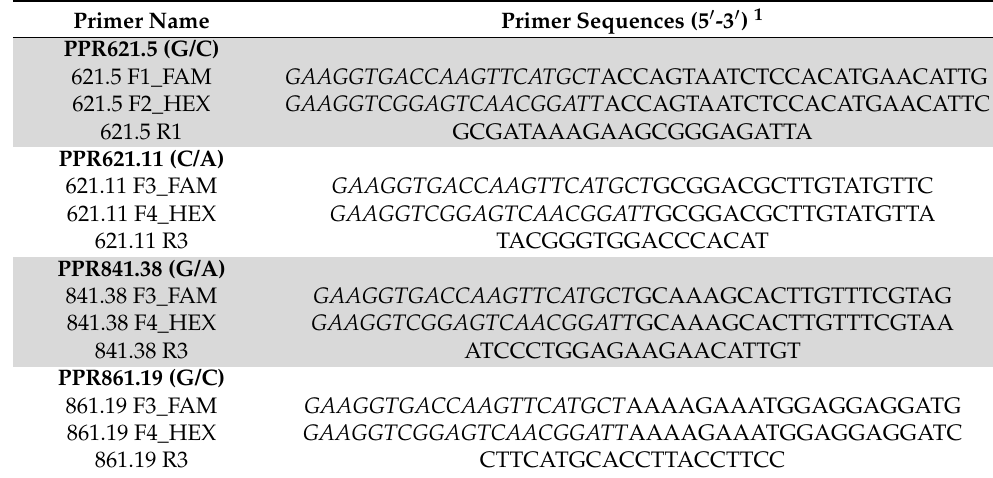
Table 1. KASP primers designed for the SNPs PPR621.5, PPRR621.11, PPR841.38, and